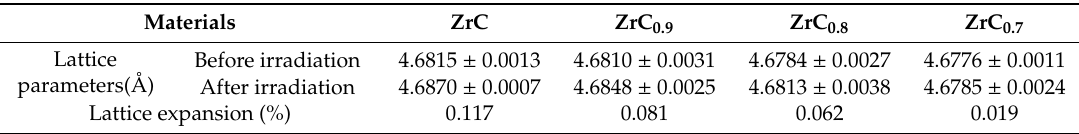
Figure 4. Grazing incidence X-ray di ff raction (GIXRD) of ZrC x with di ff erent stoichiometries before and after irradiation. ( a ) ZrC; ( b ) ZrC 0.9 ; ( c ) ZrC 0.8 ; ( d ) ZrC 0.7 . Table 2. Lattice parameters and lattice expansion of ZrC x with di ff erent stoichiometries before and after